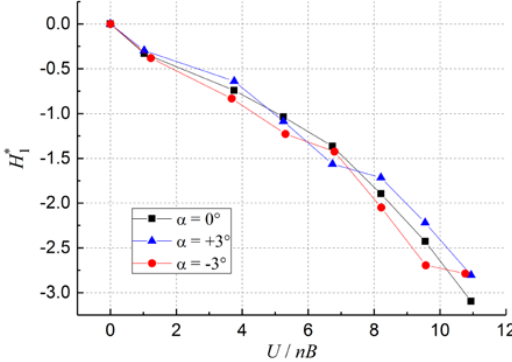
Figure 14. Aerodynamic derivative *